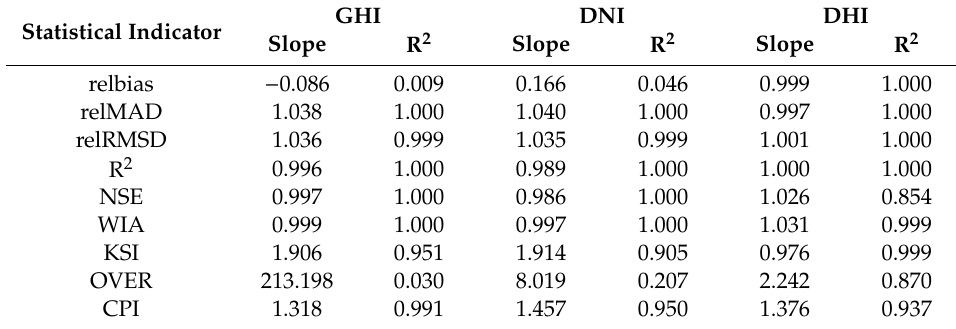
Table 5. Slope and R 2 of the linear fit of statistical indicators calculated with one year of measured and modeled data versus their actual values calculated in the whole period